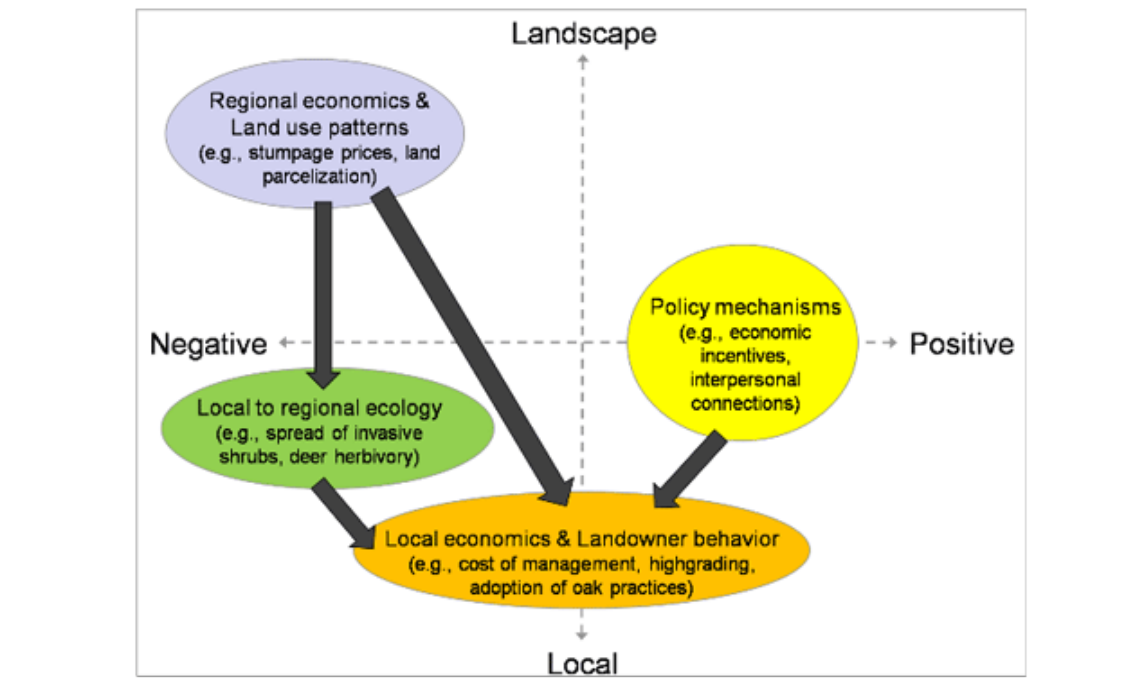
Fig. 3 . The relative spatial scale, direction of influence, and general relationships of key system features in the context of oak regeneration, as identified through an analysis of in-depth interviews with 32 regional natural resource professionals in the Driftless Area of the